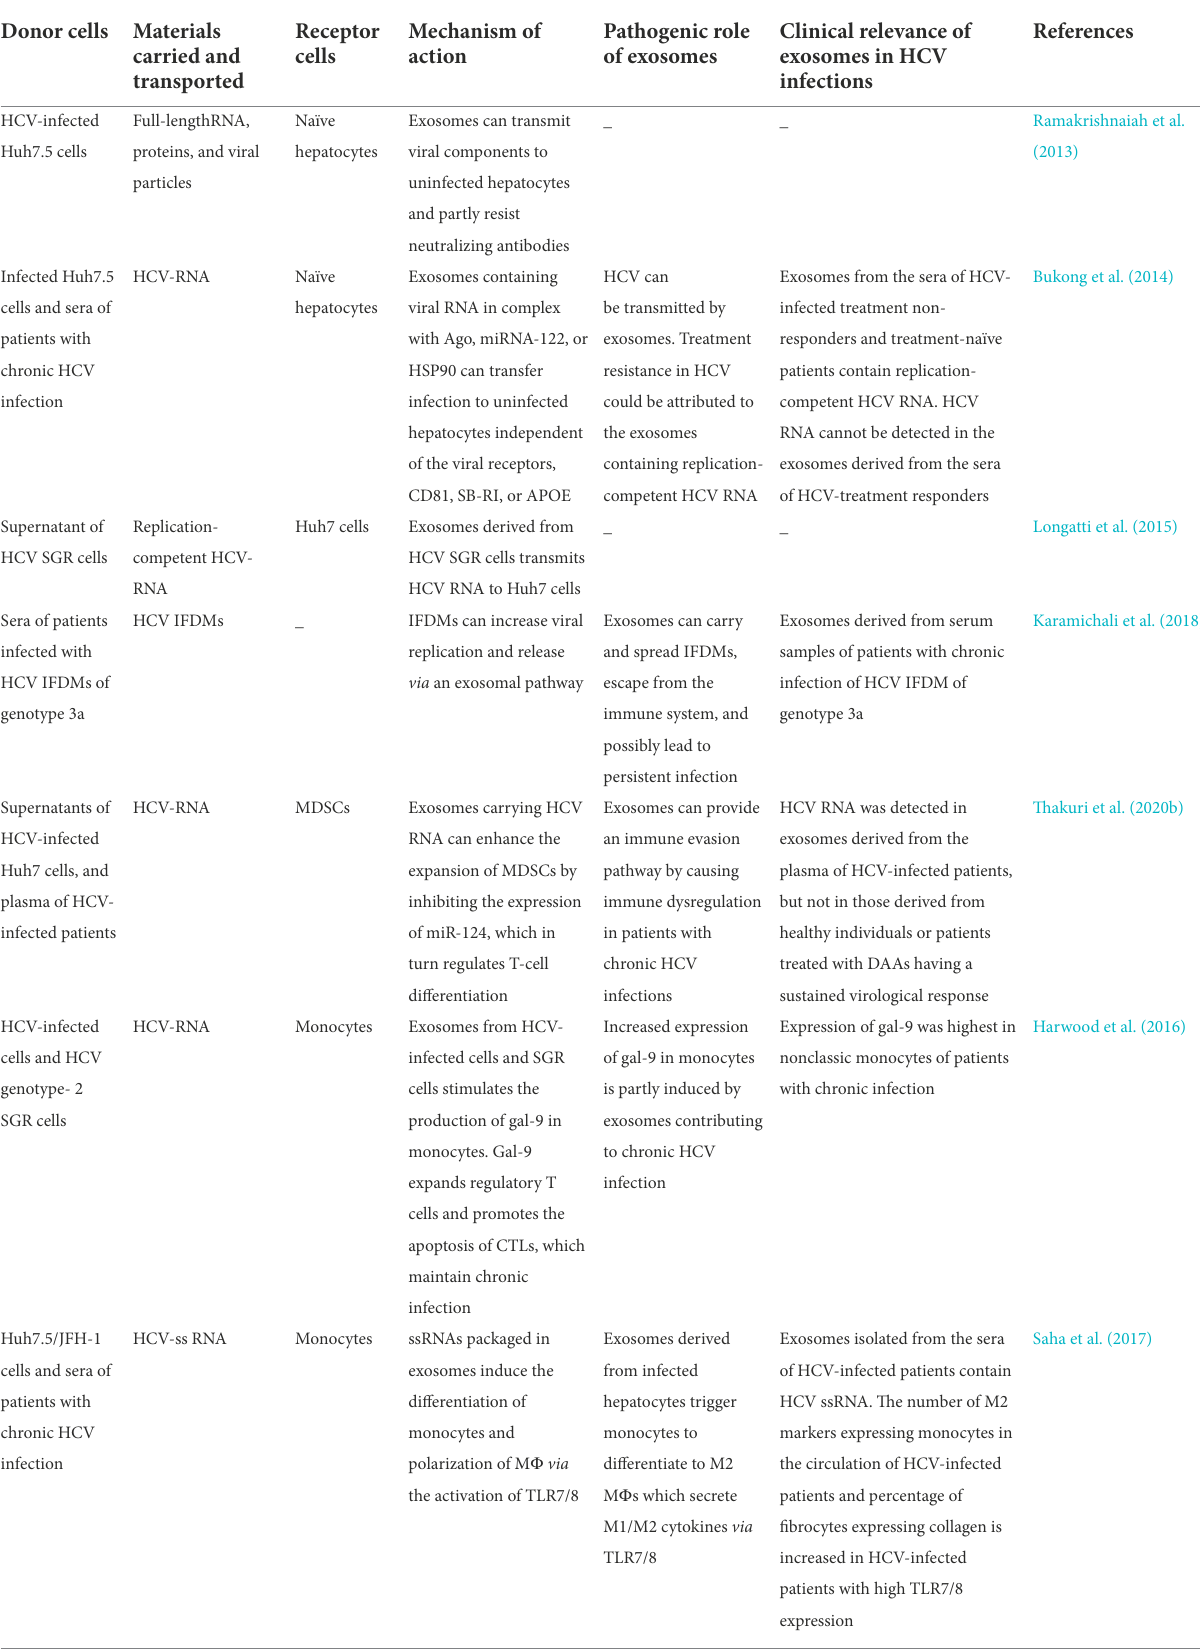
TABLE 2 Exosomes promote HCV infection by transporting viral